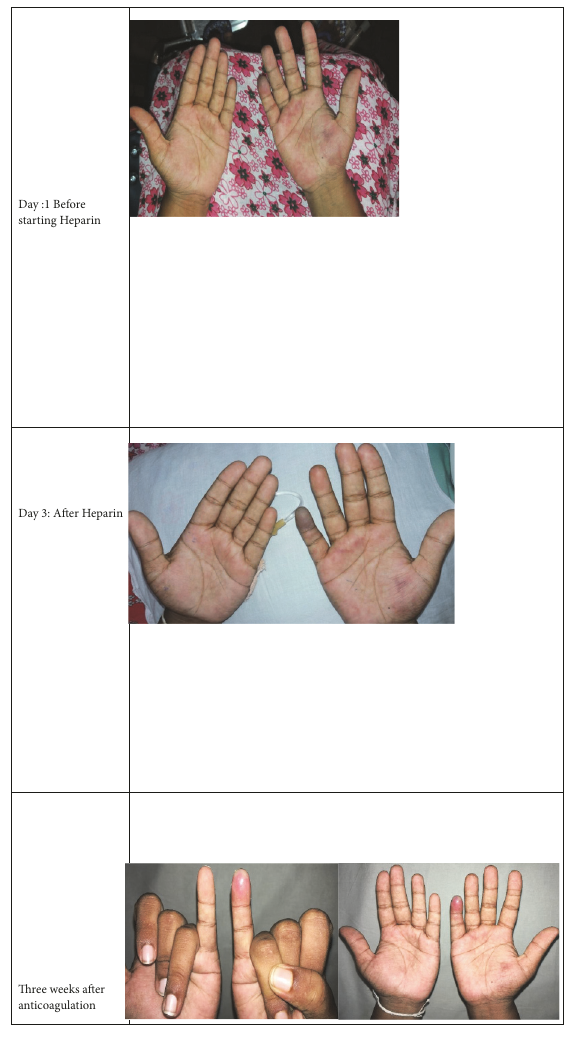
Figure 1: Sequential changes of affected finger with heparin/ anticoagulation